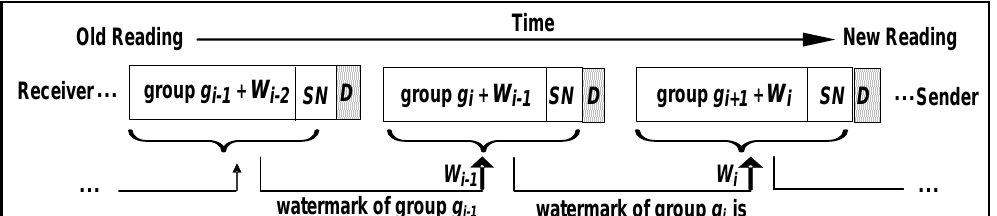
Figure 2. Backward-chaining watermark embedding